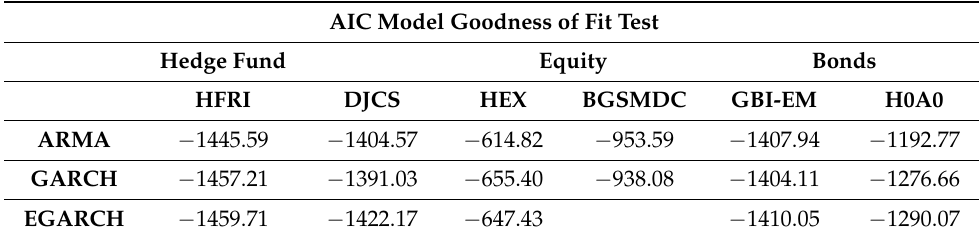
Table 7. AIC model goodness of fit test for ARMA, GARCH and EGARCH. Source: